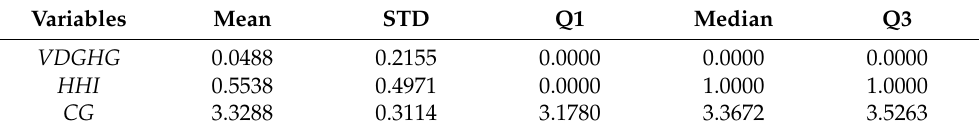
Table 2. Descriptive